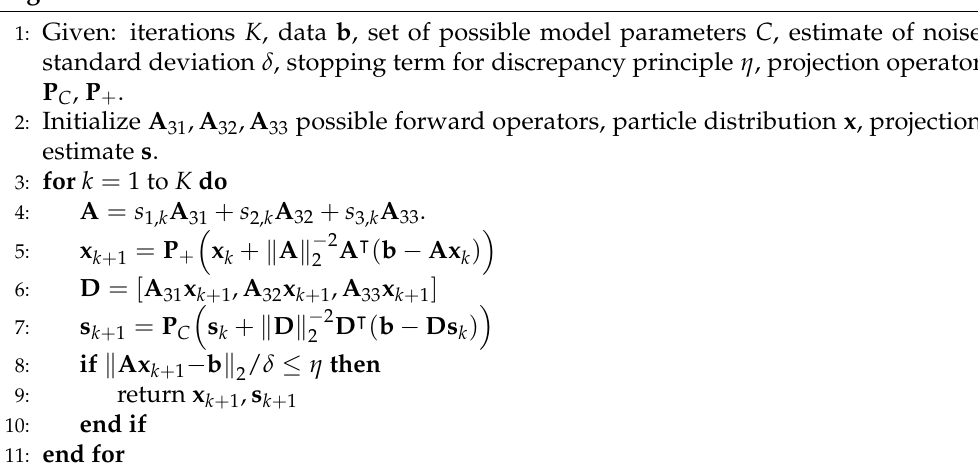
Algorithm 1 Model Estimation For Sensitive